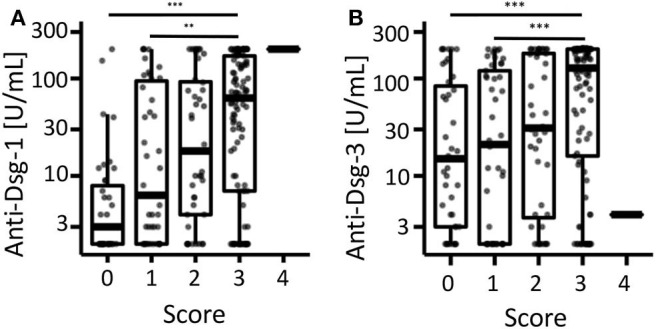
Correlation of anti-desmoglein-antibodies with the retrospective clinical score. The individual serum concentrations of (A) anti-desmoglein-1- and (B) anti-desmoglein-3-antibodies were depicted after stratification according to the retrospective score (0 = clear, 1 = almost clear, 2 = mild, 3 = moderate, 4 = severe). *** Indicates P < 0.001, Kruskal-Wallis-test with Dunn's post hoc test as post hoc and Holm's p-value adjustment.